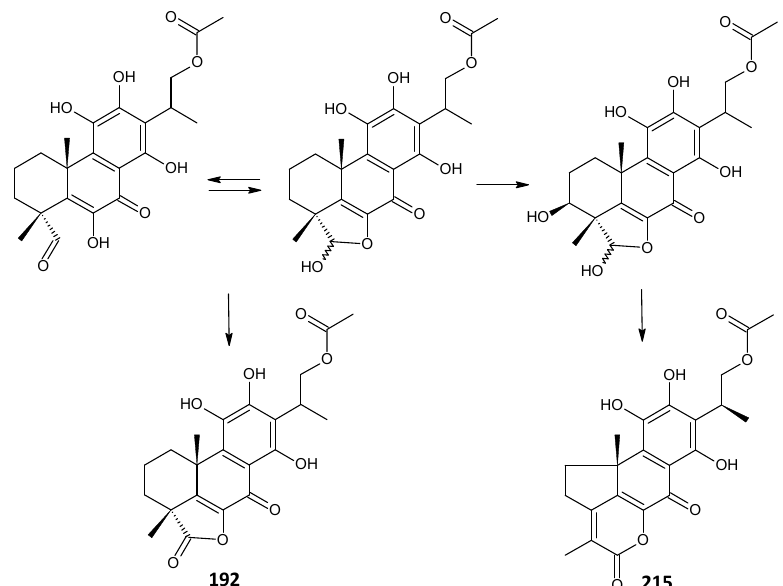
Scheme 9. Biosynthesis of lactone derivative of 16- O -acetylcoleon C ( 192 ) and edulon A ( 215 ) [26].